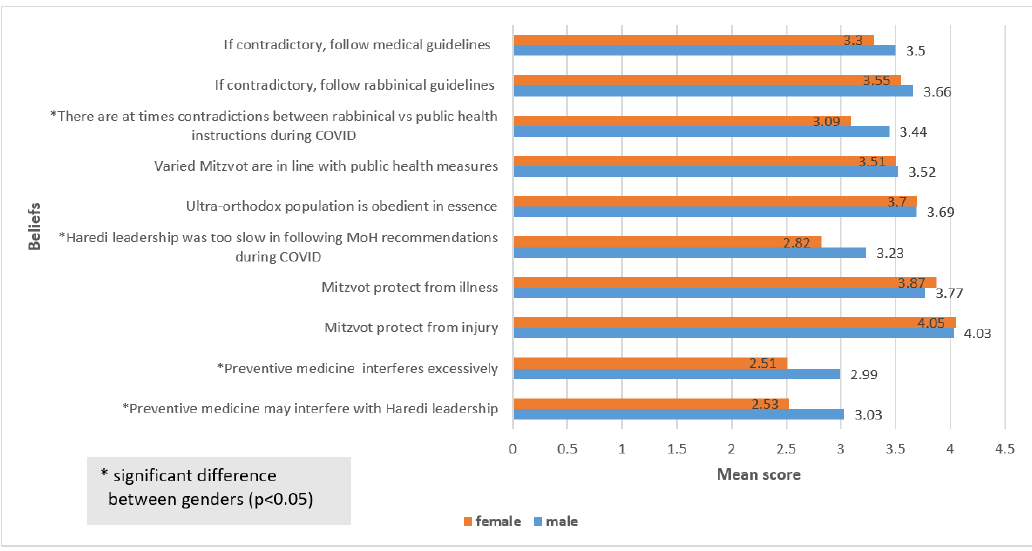
Figure 2. Mean scores of beliefs of males and females concerning religious versus public health measures to mitigate COVID ‐ 19 infection (N = 405), on a scale of 1 (do not believe at all) to 5 (fully believe).